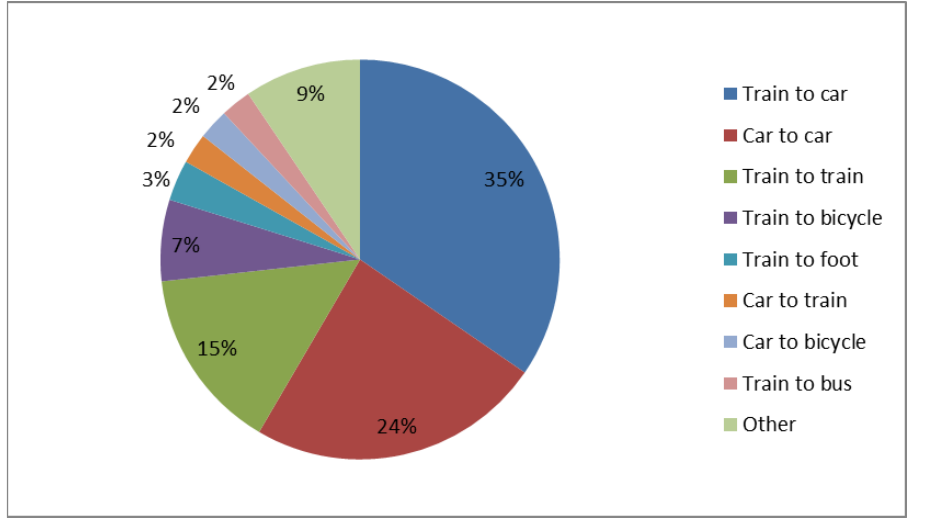
Figure 4. Modal shift of the main transport mode when commuting to the satellite office versus commuting to the headquarter office (MOBI, 2012)